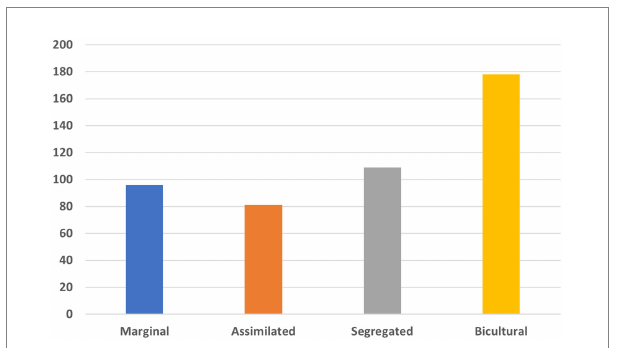
FIGURE 1 Acculturation orientation: marginal 21%, assimilated 17.5%, segregated 23.5%, bicultural 39.4%.